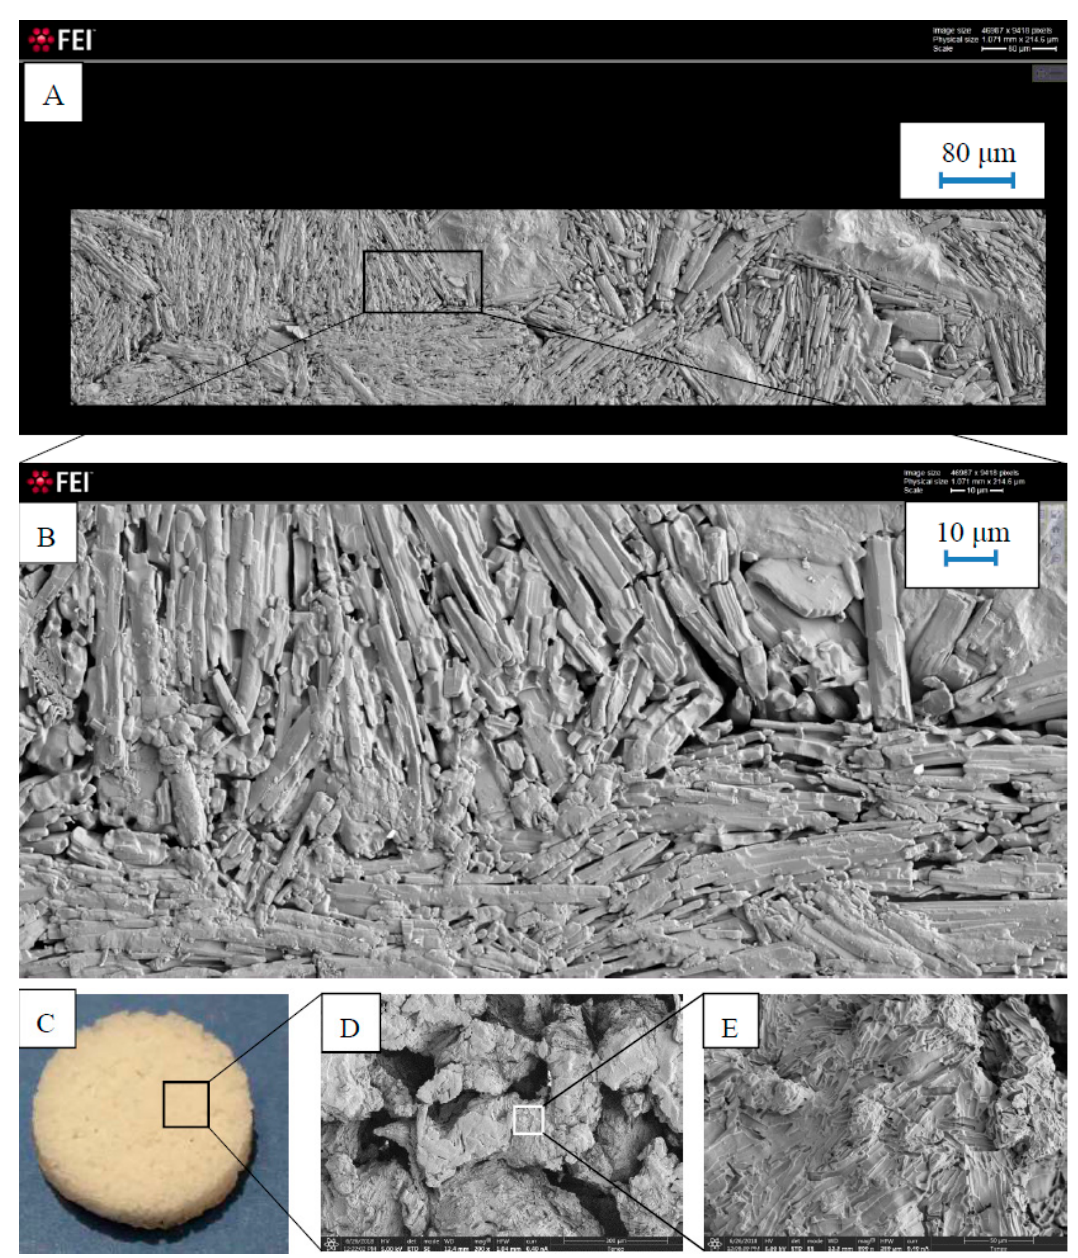
Figure 5. SEM images of USAC tablets before ( A , B ) and after drug dissolution ( D , E ). ( C ) is a digital photograph of the matrix after dissolution testing. Microphotograph 5A was obtained by Microsoft HD View 3.3 software. Magnifications of microphotographs 5B, 5D, and 5E are 5920×, 200×, and 800×, respectively.